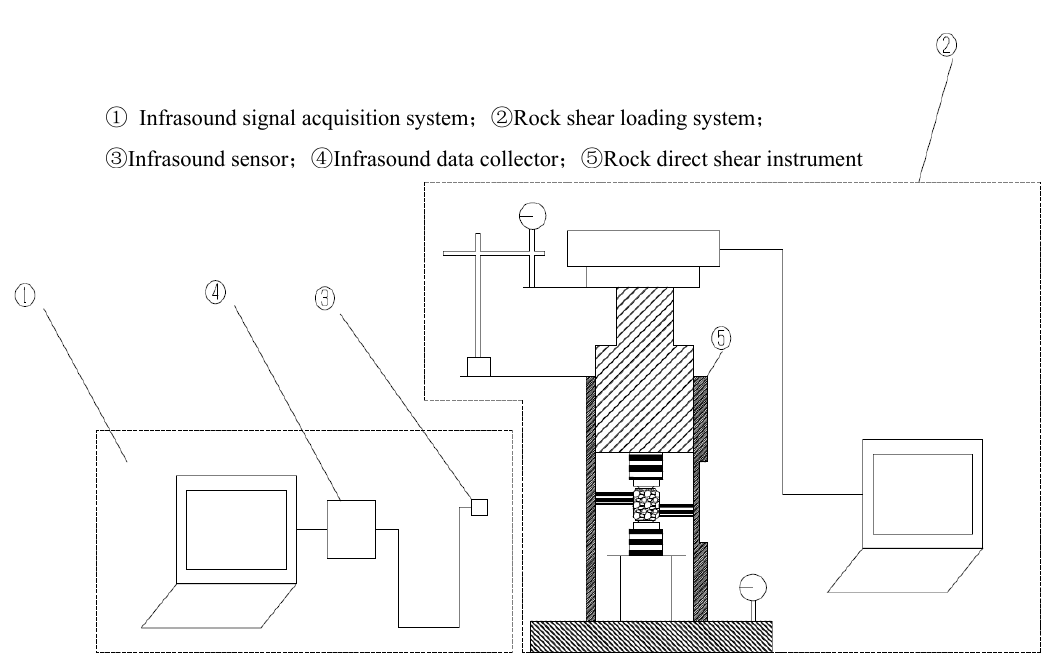
Figure 1. Experiment apparatus.